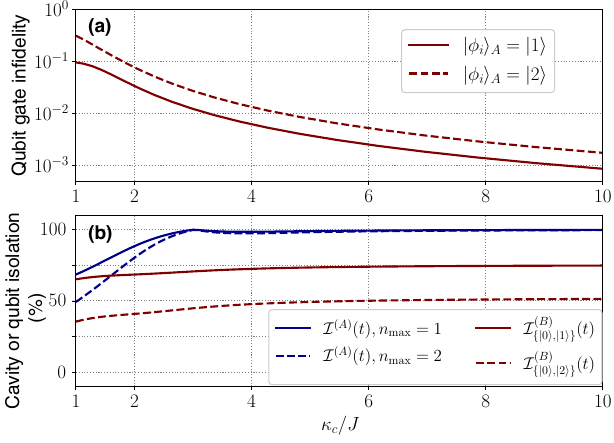
FIG. 3. (a) State-averaged infidelity of the cavity-controlled steady-state qubit gate, as a function of the non-Markovianity parameter κ c / J . We consider different choices of initial cavity state: either the Fock state | φ i (cid:3) A = | 1 (cid:3) (solid) or | 2 (cid:3) (dashed), and take θ eff = π/ 6. These different initial cavity states result in dif- ferent gate operations. Infidelity tends to zero in the Markovian limit. (b) Isolation functions for both qubit and cavity as a func- tion of the non-Markovianity parameter κ c / J . We take a fixed evolution time t = π/(cid:4) eff and θ eff = π/ 6. Blue curves denote the cavity isolation I ( A ) ( t ) ; cf. Eqs. (7) and (33). Red curves denote ( t ) ( (cid:3) = 1, 2) that the conditional qubit isolation function I ( B ) {| 0 (cid:3) , | (cid:3) (cid:3)} is an upper bound for the qubit isolation I ( B ) ( t ) ; see Eq. (34). We see strongly nonreciprocal behavior [i.e., I ( A ) ( t ) (cid:22) 1, I ( B ) ( t ) < 1] even away from the Markovian limit. As discussed in the main text, when calculating I ( A ) ( t ) , we truncate the cavity Fock space to n max photons for simplicity; the solid (dashed) curve is for n max = 1 ( n max =